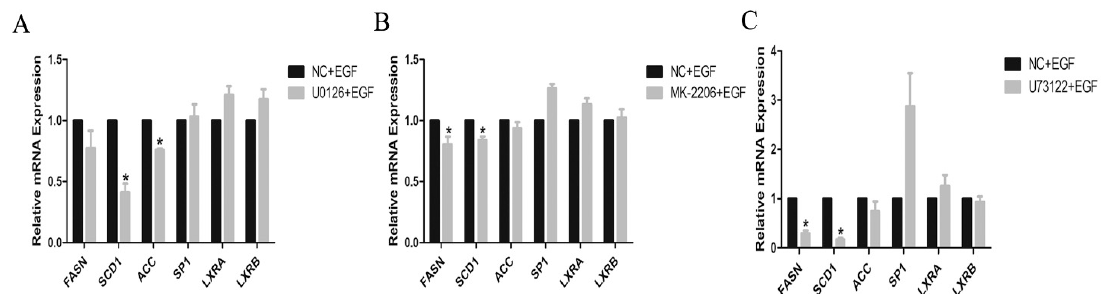
Figure 6. Effect of the protein inhibitor on the expressions of genes involved in lipid metabolism in GMECs. ( A ) GMECs were treated with 500 nM MK-2206 (Akt inhibitor) and 50 ng/mL EGF for 24 h, to investigate the mRNA levels of genes involved in lipid metabolism in GMECs. ( B ) GMECs were treated with 10 µM U0126 (MEK inhibitor) and 50 ng/mL EGF for 24 h, to investigate the mRNA levels of genes involved in lipid metabolism in GMECs. ( C ) GMECs were treated with 20 µM U73122 (PLC- γ 1 inhibitor) and 50 ng/mL EGF for 24 h, to investigate the mRNA levels of genes involved in lipid metabolism in GMECs. Values are presented as mean ± SD of three independent experiments. * Means p < 0.05.